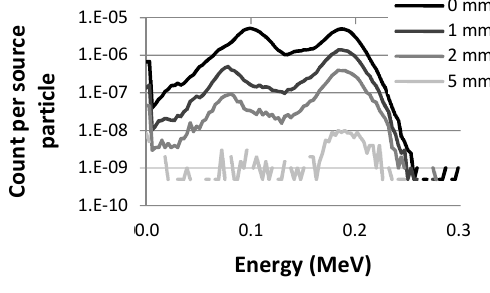
Fig. 14. Simulated spectra of shielded HEU